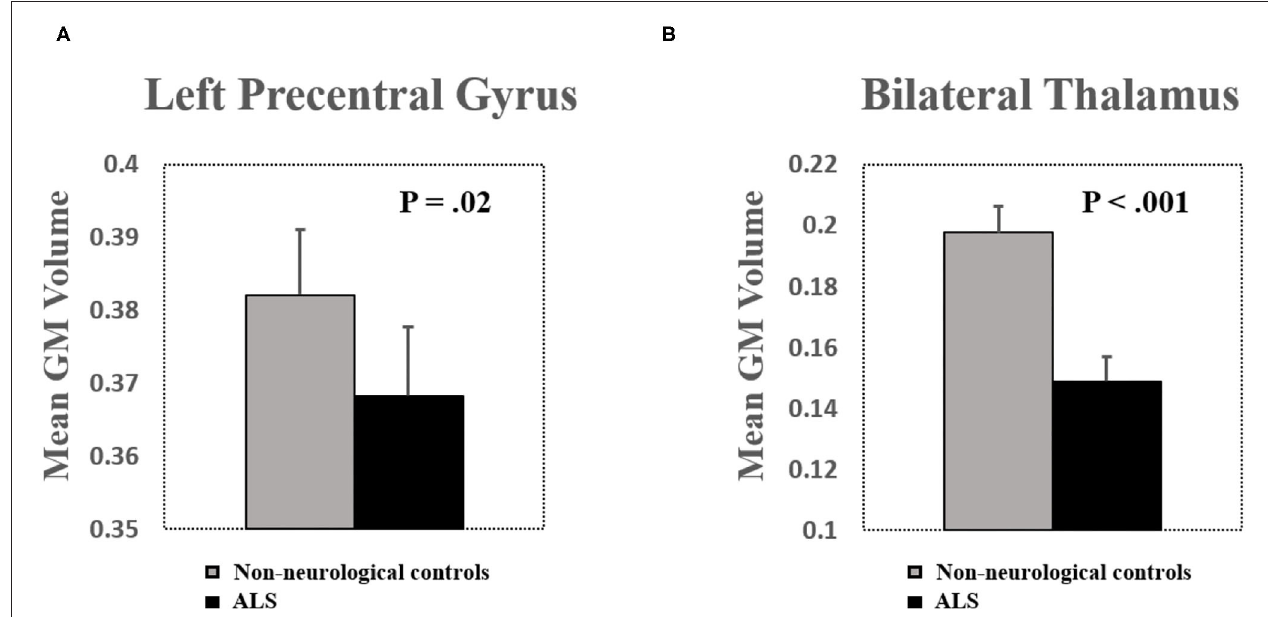
FIGURE 2 | (A) Significant brain volume atrophy was found in the left precentral gyrus in patients with ALS. (B) Significant brain volume atrophy was found in the bilateral thalamus in patients with ALS. Bar plots show mean gray matter (GM) volume after controlling for total intracranial volume (TIV) as a covariate of noninterest. Error bars show SEs.